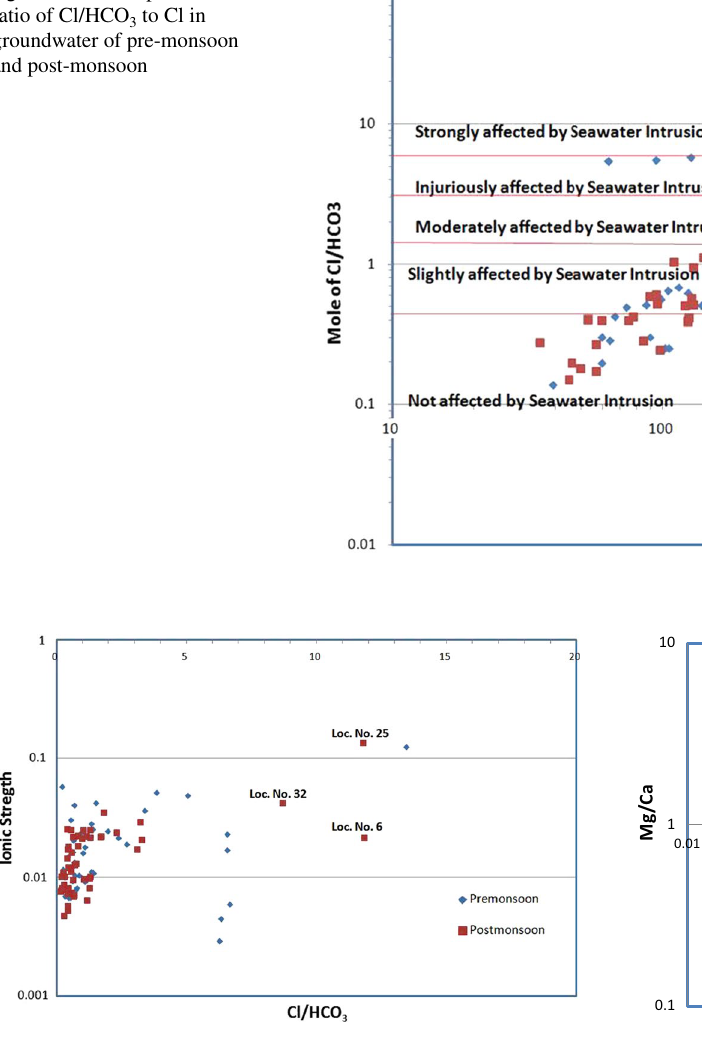
3 and ionic strength of the